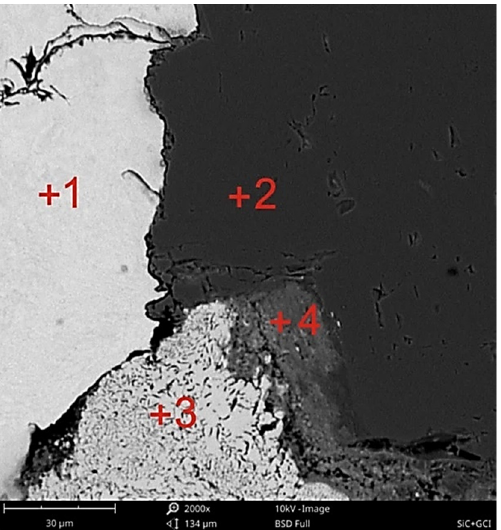
Figure 4. Composite microstructure of the gray cast iron– β -SiC in the area of the matrix contact with the reinforcement containing marked EDS analysis points, SEM, mag. 2000×, nonetched sample; 1— β -SiC reinforcement; 2—metallic matrix (gray cast iron); 3—transition zone 1; 4—transition zone 2.